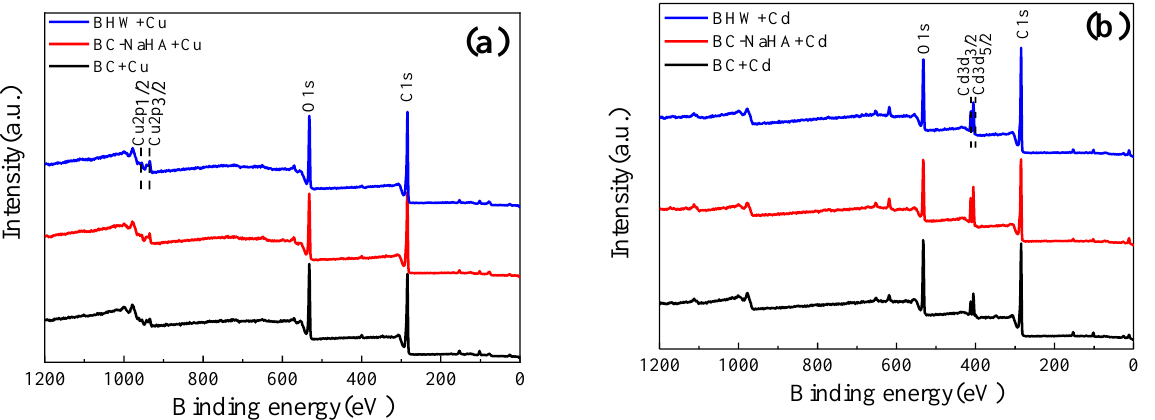
Figure 7. ( a ) XPS full spectrum of BC, BC-NaHA, and BHW before and after Cu 2+ ion adsorption; ( b ) XPS full spectrum of BC, BC-NaHA, and BHW before and after Cd 2+ ion adsorption. Figure 8 indicates the C1s high-resolution spectra before and after the adsorption of Cu 2+ (or Cd(II)) ions by BC, BC-NaHA and BHW. As shown in Figure 8a, C=C/C-C, O-C=O and C-OH in the C1s spectrum are located at 284.60 eV, 288.65 eV and 286.10 eV, respectively [22,32]. Before immobilizing heavy metal ions, the contents of C=C/C-C, O-C=O and C-OH in the spectrum of BC are 66.4%, 13.2% and 20.4%, respectively. As for BC-NaHA, the content of C=C/C-C, O-C=O and C-OH in the spectrum are 59.90%, 12.7% and 27.4%, respectively. However, the contents in the BHW spectrum are 51.1%, 11.1% and 37.8%, respectively. The result shows that the BHW material has the highest oxygen content (48.9%) among the three materials, followed by BC-NaHA (40.1%) and BC (33.6%) due to the introduction of more oxygen-containing functional groups by wood vinegar.